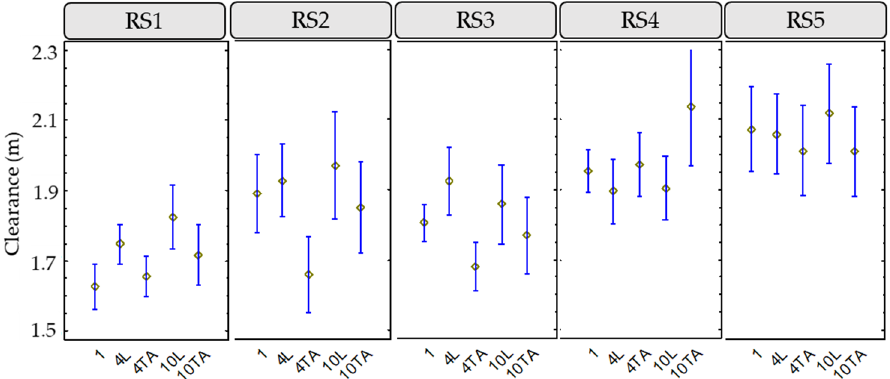
Figure 5. Means and 95% LSD intervals for lateral clearance, considering road segment and peloton configuration.